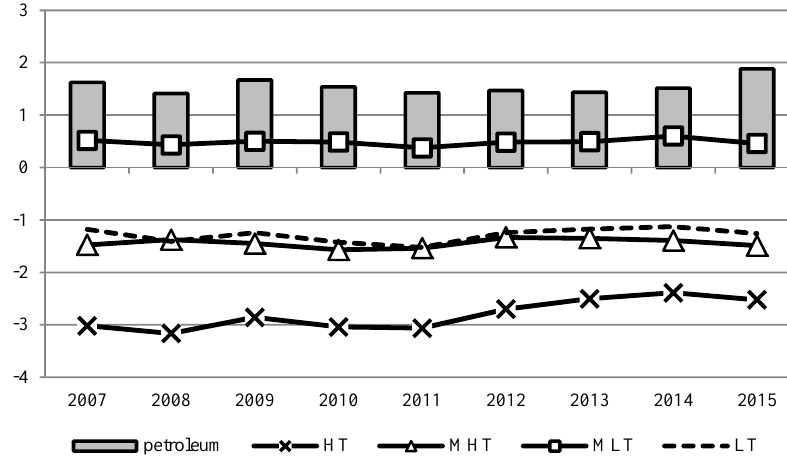
Source: own elaboration based on United Nations Commodity Trade Statistics